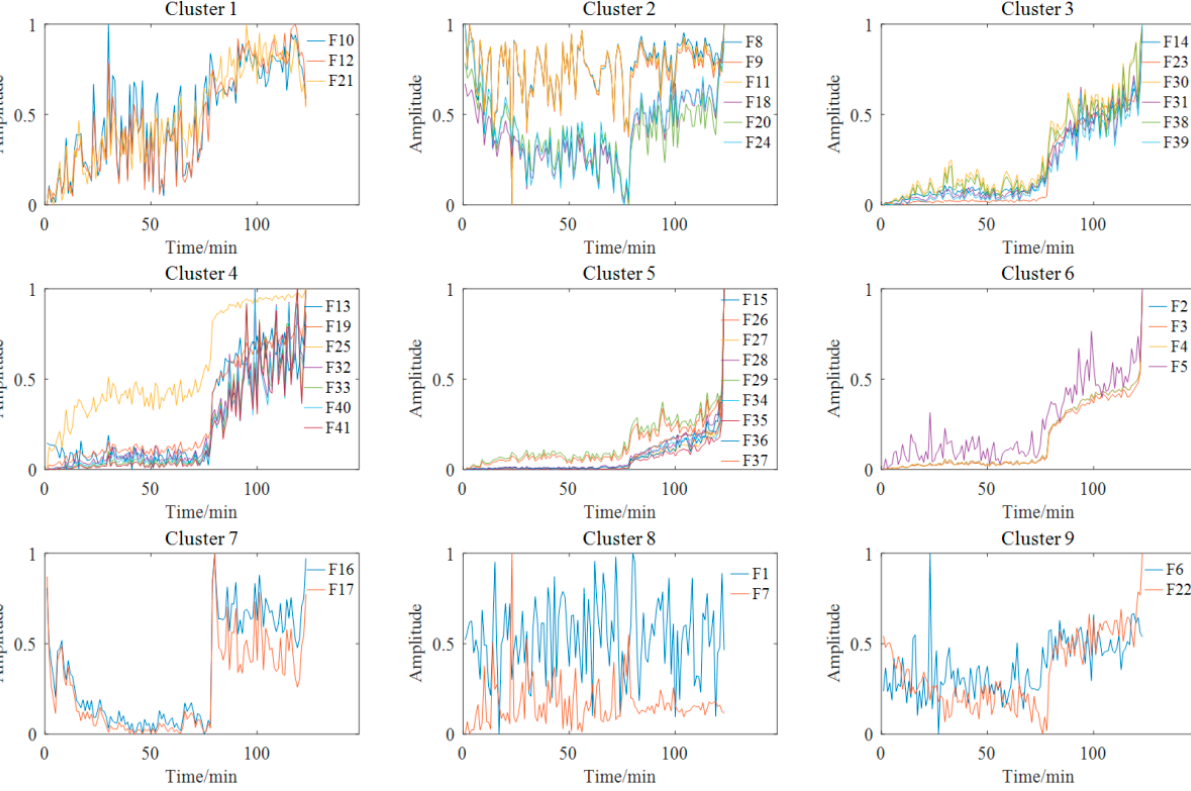
Figure 22. Feature clustering results of Bearing 1-1.